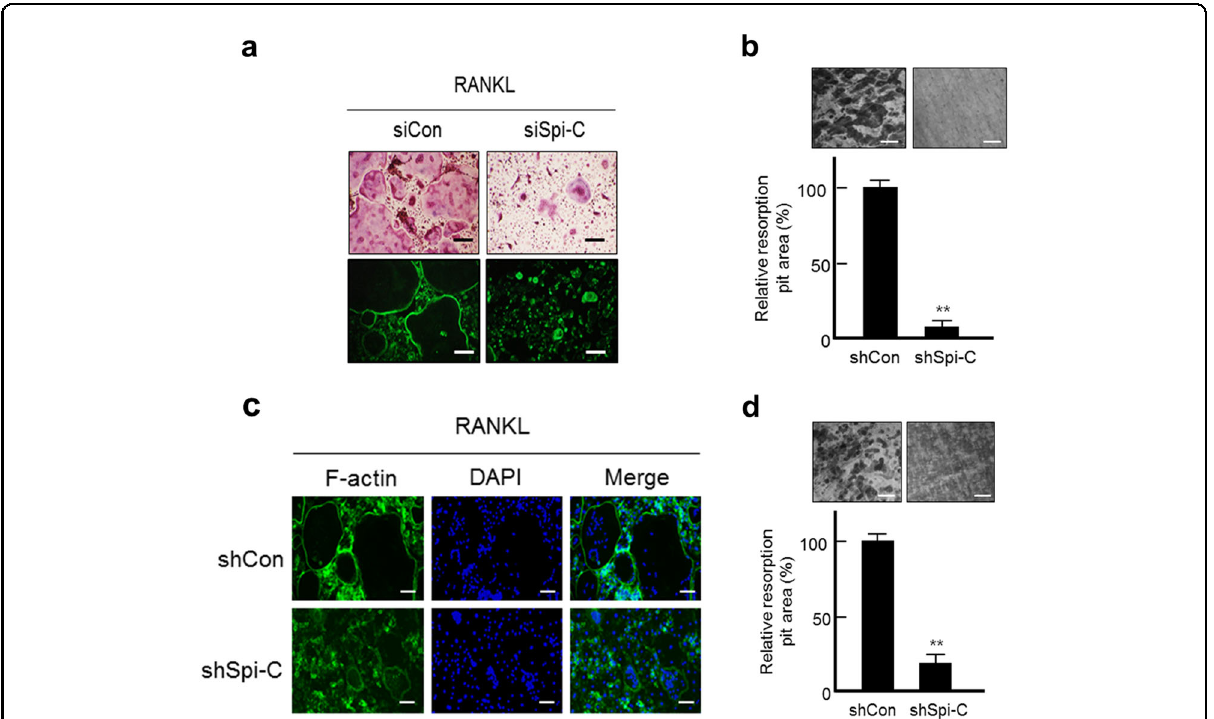
Fig. 4 Spi-C promotes RANKL-induced actin ring formation and bone resorption. a BMMs transfected with a scrambled nontargeting siRNA (siCon) or Spi-C siRNA (siSpi-C) were cultured with RANKL (200ng/ml) for 5 days. Then, the cells were fi xed and subjected to TRAP staining (upper panel) or immuno fl uorescence staining for F-actin (lower panel). Scale bars, 100 μ m (original magni fi cation, ×200). b , d BMMs b or mature osteoclasts d on dentine discs were infected with the control shRNA lentiviral vector (shCon) or Spi-C shRNA expression lentiviral vector (shSpi-C) for 24 h. After 48 h, the BMMs or mature osteoclasts were treated with 200 ng/ml of RANKL for 4 days b or 2 days d . The BMMs and the mature osteoclasts were completely removed from the dentine discs. Then, the dentine discs were stained with hematoxylin, and the resorption pits were visualized under a light microscope (upper panel). Scale bars, 200 μ m (original magni fi cation, ×200). The resorption pit areas were measured and are presented as the relative pit area (%). c Mature osteoclasts were infected with a control shRNA lentiviral vector (shCon) or Spi-C shRNA expression lentiviral vector (shSpi-C) for 24 h. After 48 h, the cells were subjected to immuno fl uorescence staining for F-actin. Nuclei stained with DAPI were observed as blue and imaged under a fl uorescence microscope. Scale bars, 100 μ m (original magni fi cation, ×200). The data are presented as the mean ± SD of three independent experiments. ** p < 0.005 vs. untreated